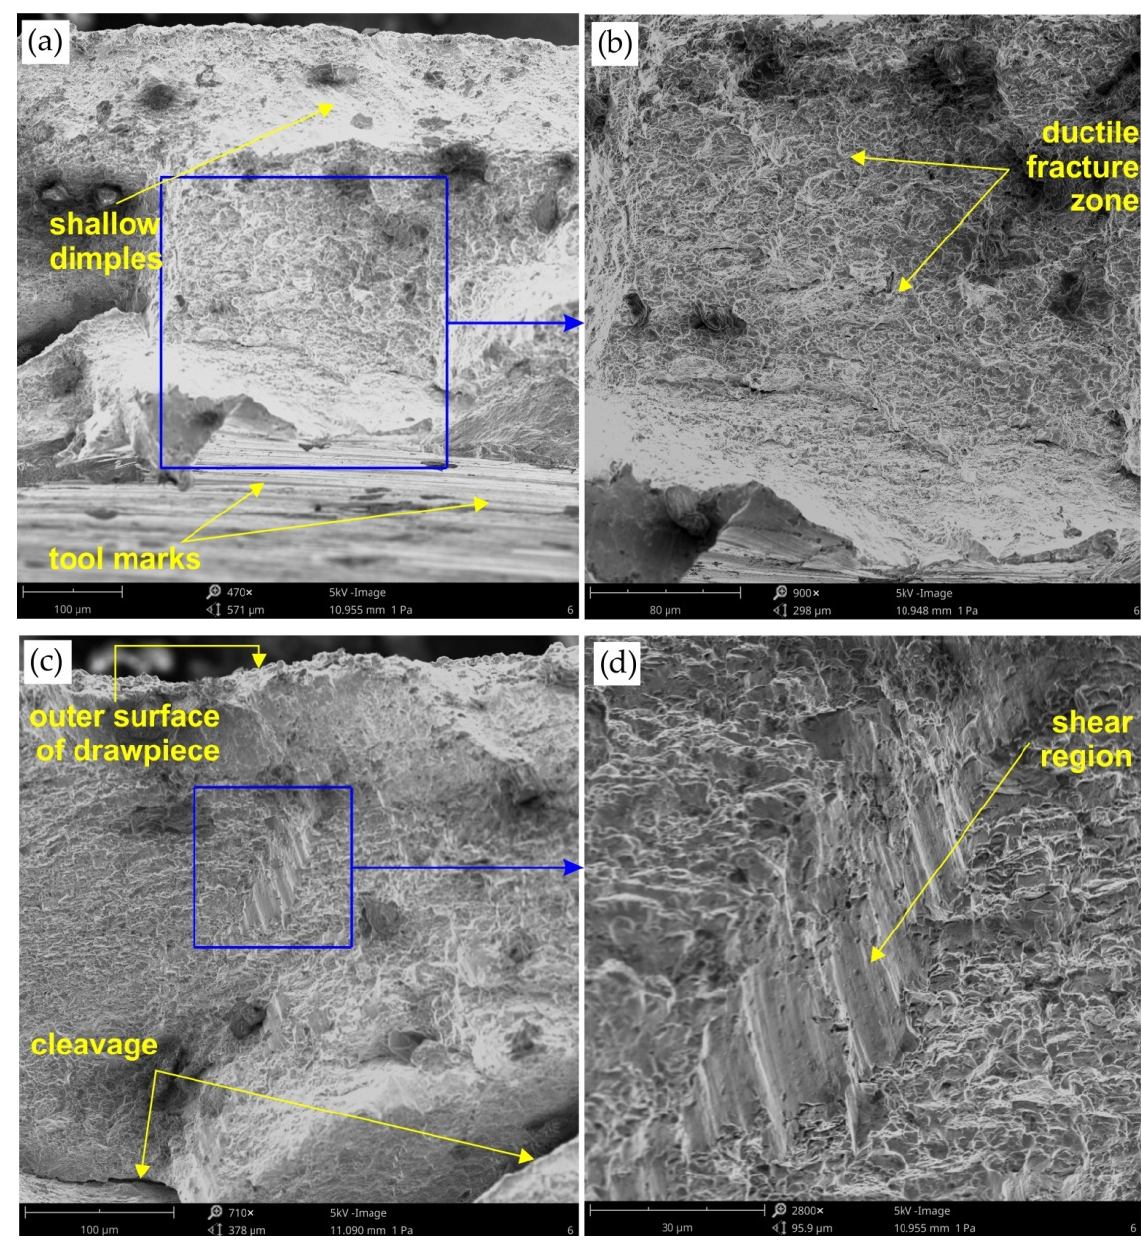
Figure 9. SEM micrographs of the fracture surface of VWACF (maximum formable wall angle α = 45°): ( a ) cross-section of the fractured surface, ( b ) view of the near-edge inner surface of the drawpiece, ( c , d ) magnification of the ductile fracture area.